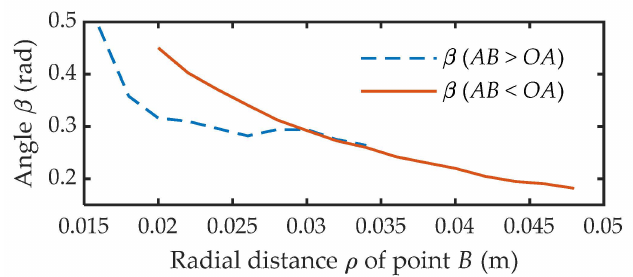
Figure 23. Calculation results of the angle β with two configurations.